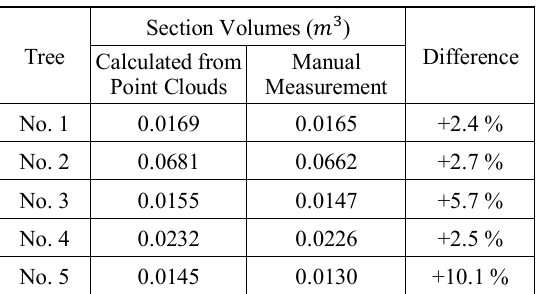
Figure 13. Point clouds of selected trees